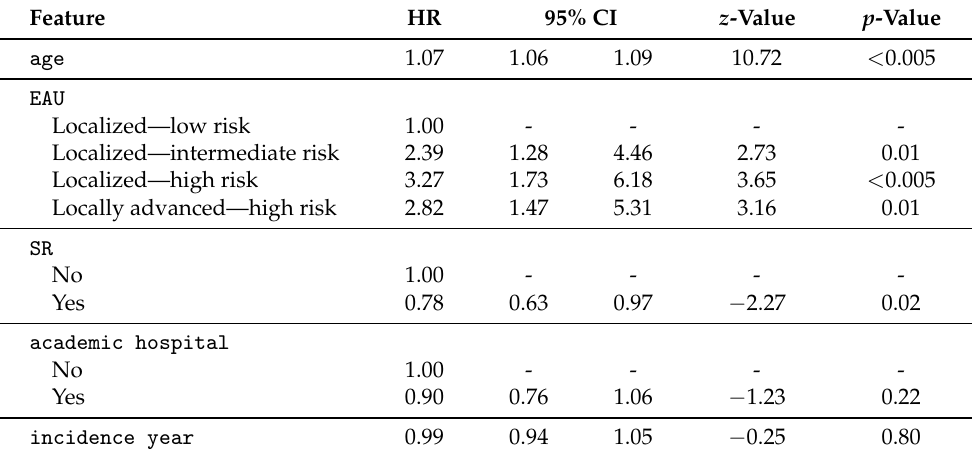
Figure 5. Interaction effects between SR and the two most relevant features: ( A ) age and ( B ) EAU (en- coded as 1—low risk/localised, 2—intermediate risk/localised, 3—high risk/localised, and 4—high risk/locally advanced). In both cases, artificial jitter was added along the x -axis to better show the point density. Table 4. Results of the CPH multiple